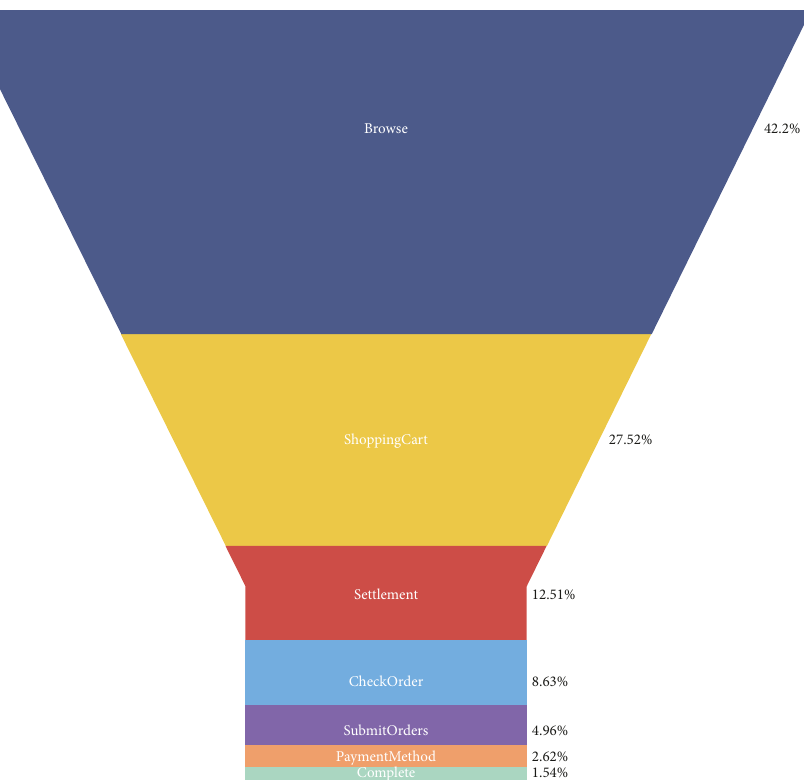
Figure 10: Funnel diagram visualization based on user dynamics.